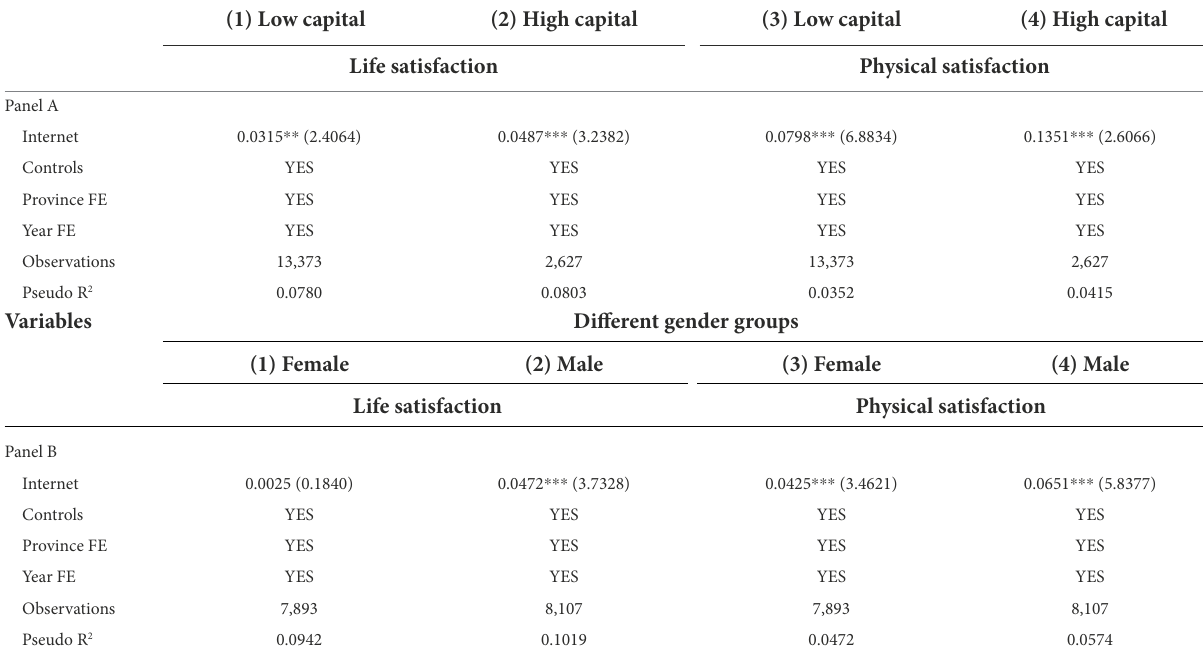
TABLE 9 Individual